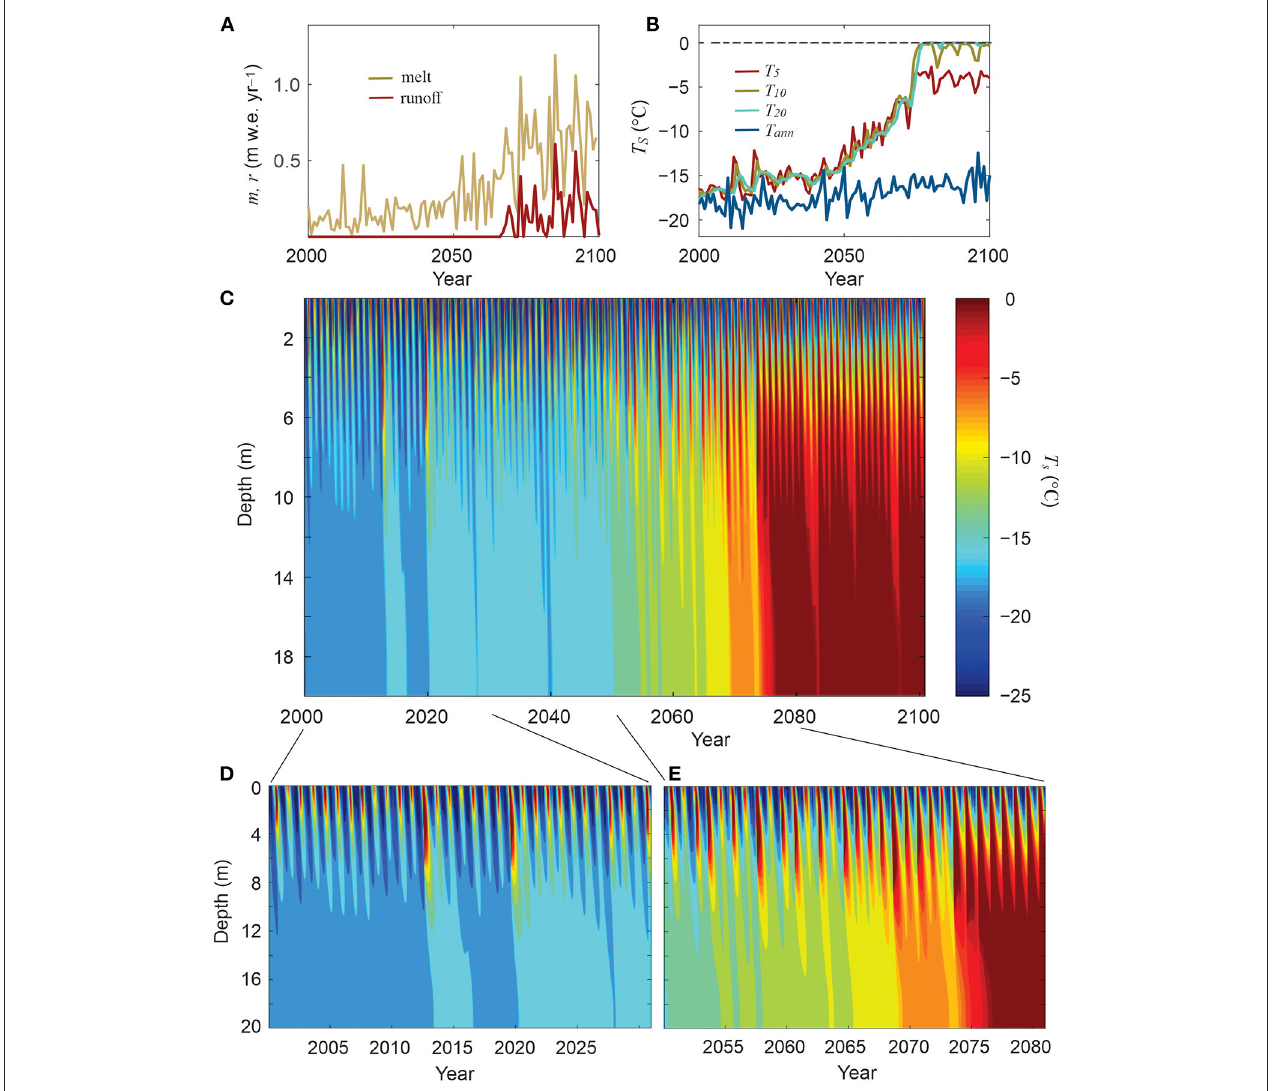
FIGURE 5 | Modelled firn evolution at DYE-2, Greenland as per Figure 4 but prescribing a 50% increase in precipitation at DYE-2. (A) Modelled melt and runoff. (B) Mean annual air temperature and firn temperatures at 5-, 10-, and 20-m depth. (C–E) Daily mean temperatures in the 20-m firn column from 2000 to 2100, (D) 2000 to 2030, and (E) 2050 to 2080, showing the transition to deep temperate firn in 2077.